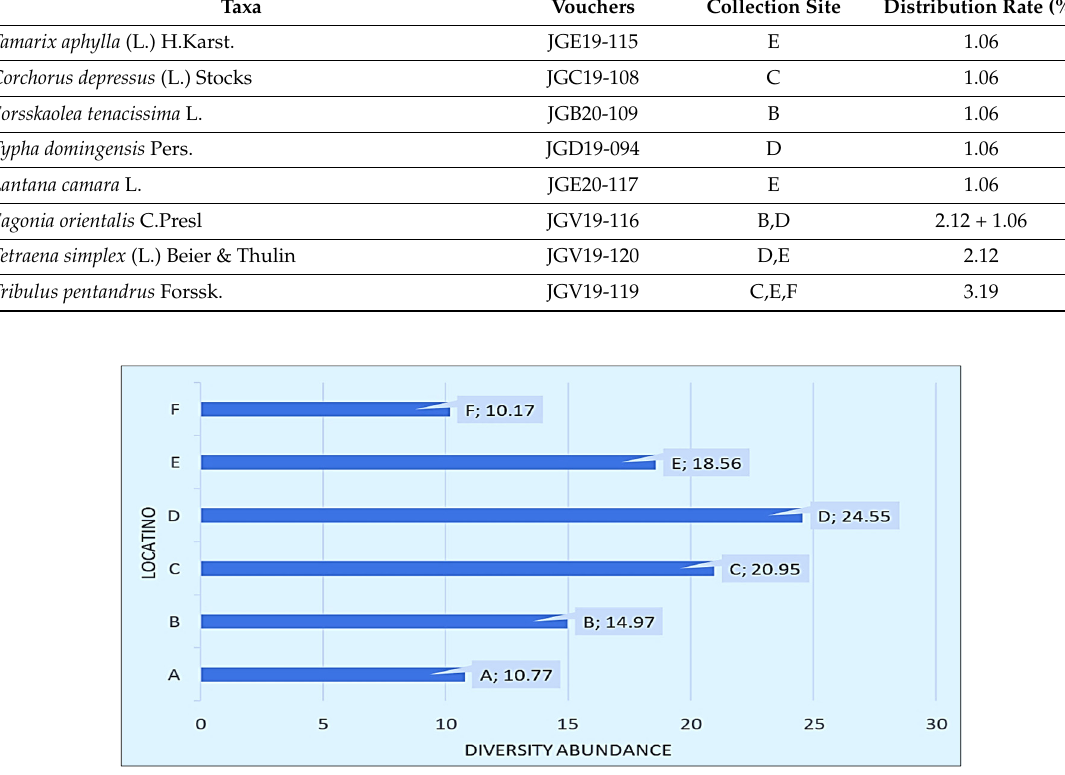
Figure 2. Flora diversity and abundance in Aljumum within the study areas.